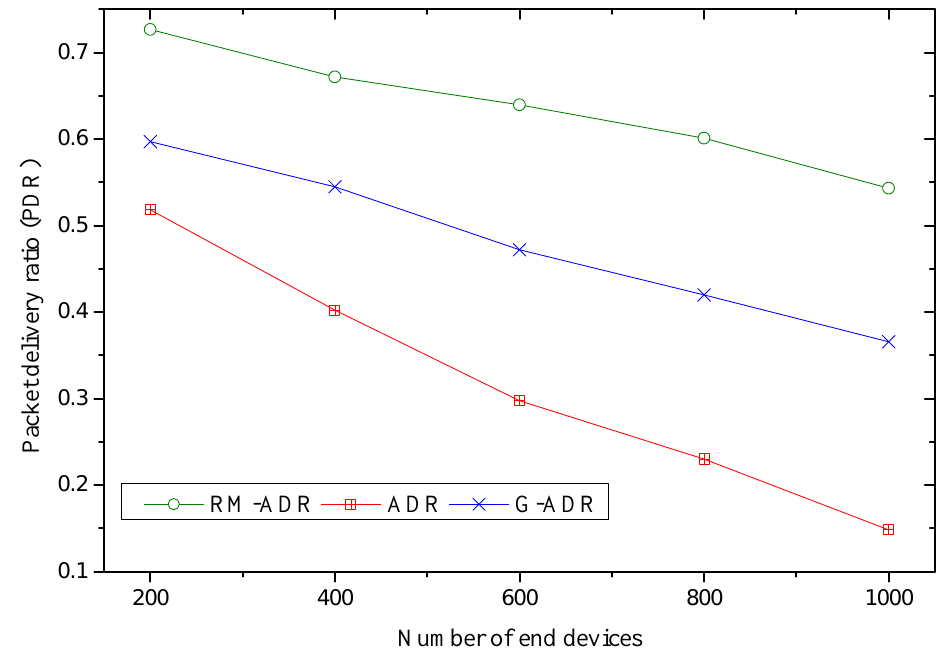
Figure 7. PDR of the proposed RM-ADR and existing ADRs.